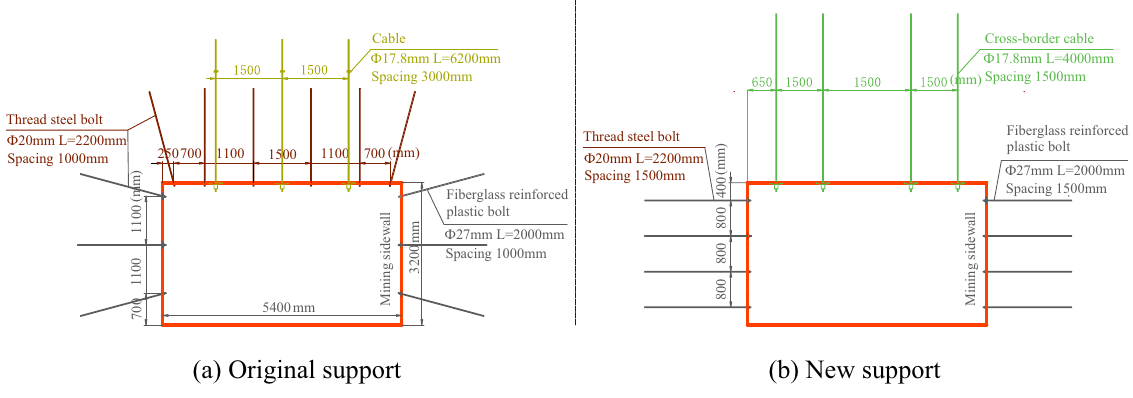
Figure 22. Comparison of support parameters between original and new